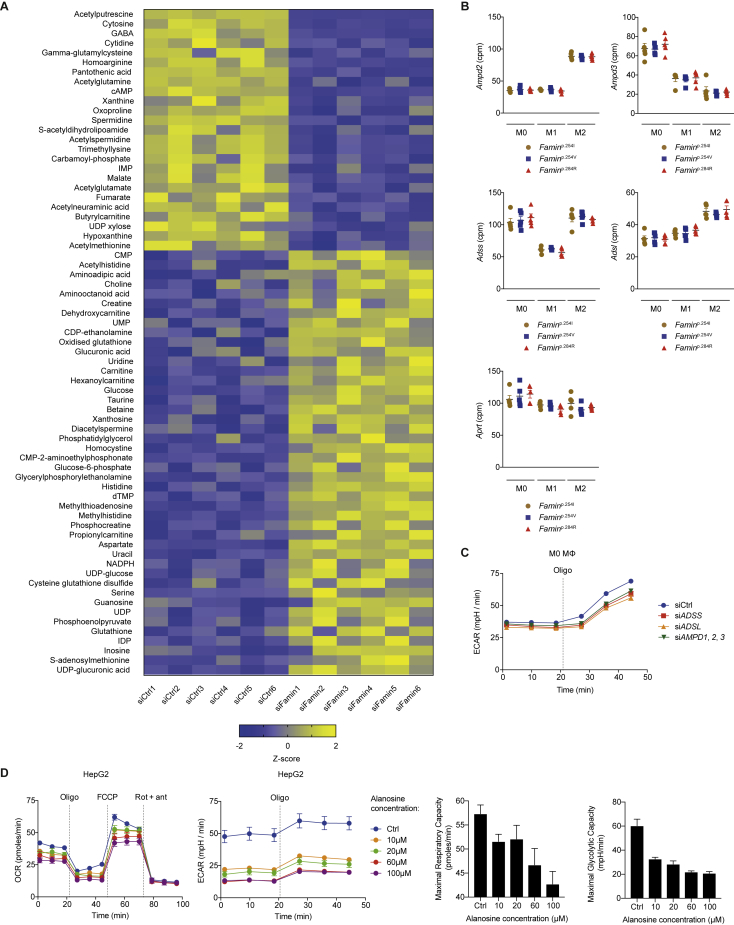
A Purine Nucleotide Cycle Operates in Macrophages and HepG2 Cells, Related to Figure 5(A) Heatmap of metabolites in control and FAMIN-silenced HepG2 cells 48 h after transfection (n = 6).(B) Ampd2, Ampd3, Adss, Adsl and Aprt expression in Faminp.254I, Faminp.254V, Faminp.284R M0, M1 and M2 macrophages (n = 5). Ampd: AMP deaminase; Adss: Adenylosuccinate synthase; Adsl: Adenylosuccinate lyase; Aprt: Adenine phosphoribosyltransferase.(C) Extracellular acidification rate (ECAR) of Faminp.254I M0 macrophages silenced for Adss, Adsl and Ampds (Ampd1, 2 and 3) or transfected with a non-targeting scrambled siRNA control. Basal ECAR measurement was followed by sequential treatment (dotted vertical lines) with oligomycin A (Oligo) (n = 3). Ampd: AMP deaminase; Adss: Adenylosuccinate synthase; Adsl: Adenylosuccinate lyase.(D) Oxygen consumption rate (OCR), and extracellular acidification rate (ECAR) with maximal respiratory and glycolytic capacities of control and FAMIN-silenced HepG2 cells treated with 10 μM, 20 μM, 60 μM, 100 μM of L-alanosine or vehicle control for 24 h. Basal OCR and ECAR measurements followed by sequential treatment (dotted vertical lines) with oligomycin A (Oligo), FCCP, and rotenone plus antimycin A (Rot + ant) (n = 3).Data are represented as mean ± SEM.